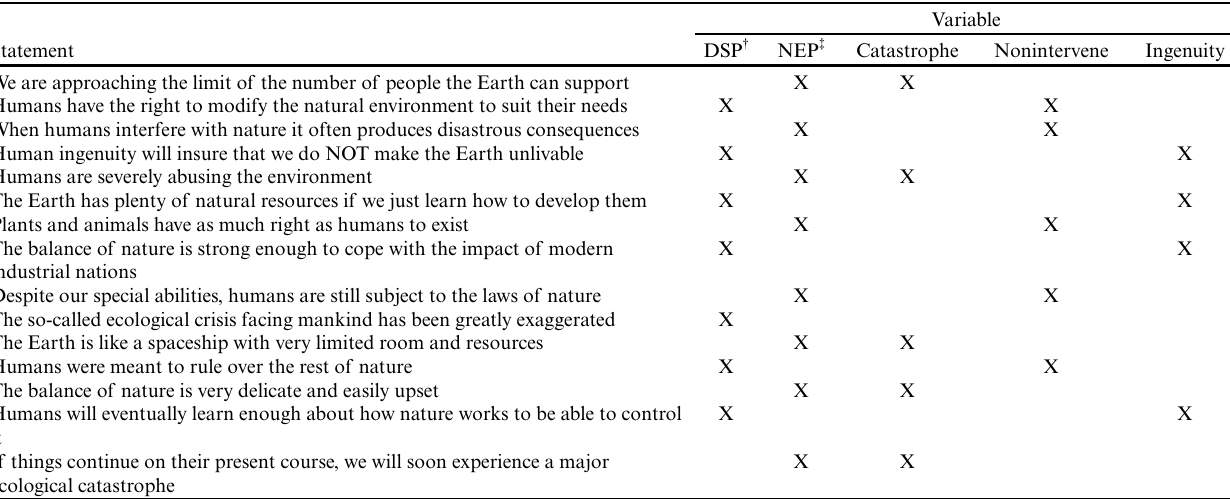
Table 2 . Derivation of environmental worldview variables (adapted from Dunlap et al.